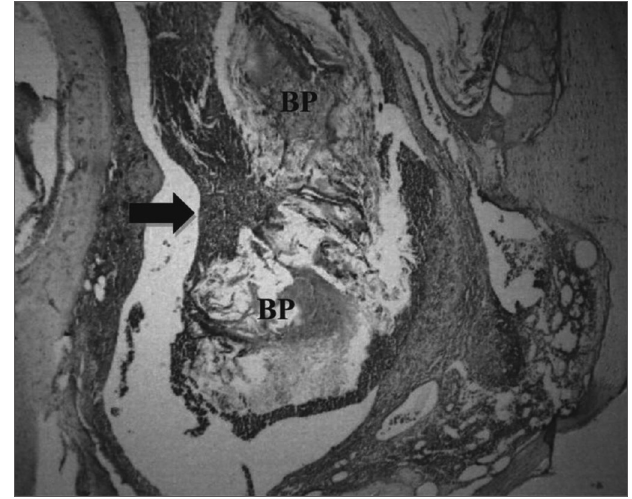
Figure 1. Experimental group at 8 weeks - Microphotography of the tympanic membrane, thickened at the point of contact; sugar cane biopolymer. Surrounded moderate subacute exudate; the biomaterial. BP= sugar cane biopolymer; LB= bulla lumen; CAE= external ear canal; thick arrow = inflammatory reaction; thin arrow =malleus. HE (40x magnification).